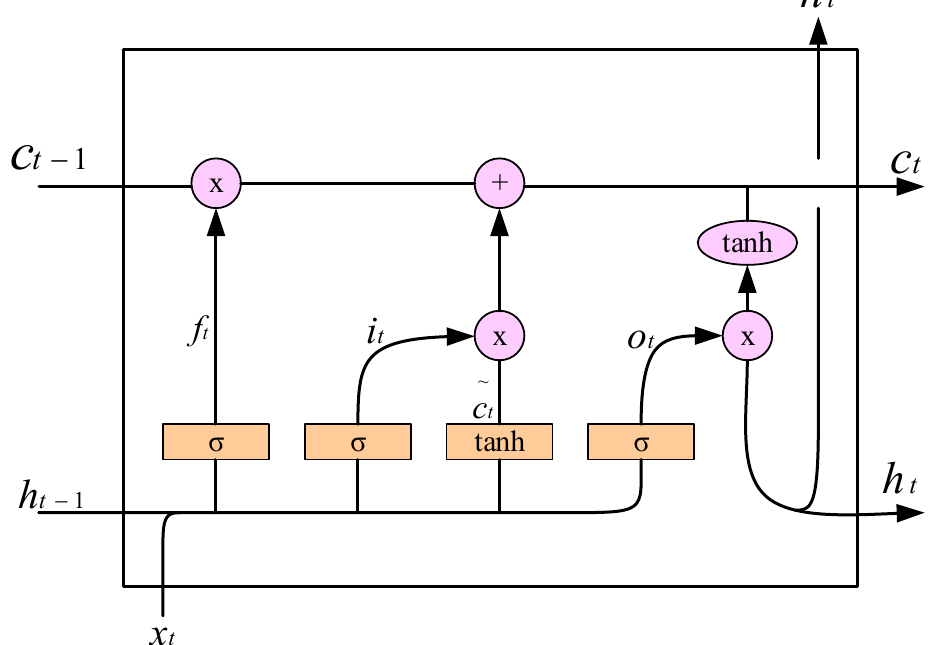
Figure 1. The basic unit structure of the LSTM network. Where “ × ” and “+” represent the matrix multiplication and matrix addition, respectively. σ is the sigmoid activation function and tanh is the tanh activation function. f t is the forget gate, i t is the input gate, O t is the output gate, h t − 1 and h t are the hidden states, x t denotes the input and C t − 1 and C t are the cell states. As can be seen from Figure 1, LSTM has three gates, namely, the forget gate f t , input gate i t and output gate O t . The